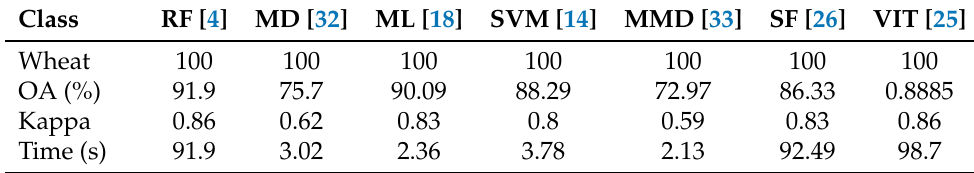
Table 1. Comparison of classification accuracy and time consumption of multiple methods